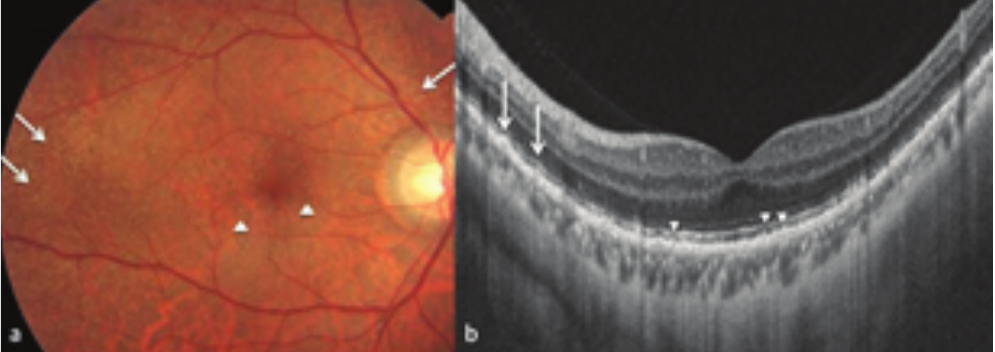
Figure 3. A case of mixed SDD. Fundus photograph shows dot-like SDD (white arrowheads) near the fovea and reticular lesions (white arrows) in the temporal perifoveal and peri-papillary area. (b) SS-OCT image through the white right arrow in subfigure “a” shows sharp peaked (white arrowheads) and broad mound-shaped deposits (white arrows) in the subretinal space suggestive of dot and reticular drusen,